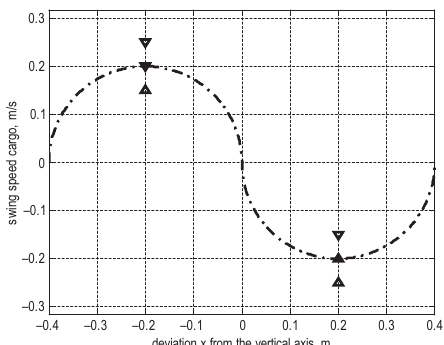
Fig. 6. Optimum phase trajectory when a restoring force presented in the mechanical system